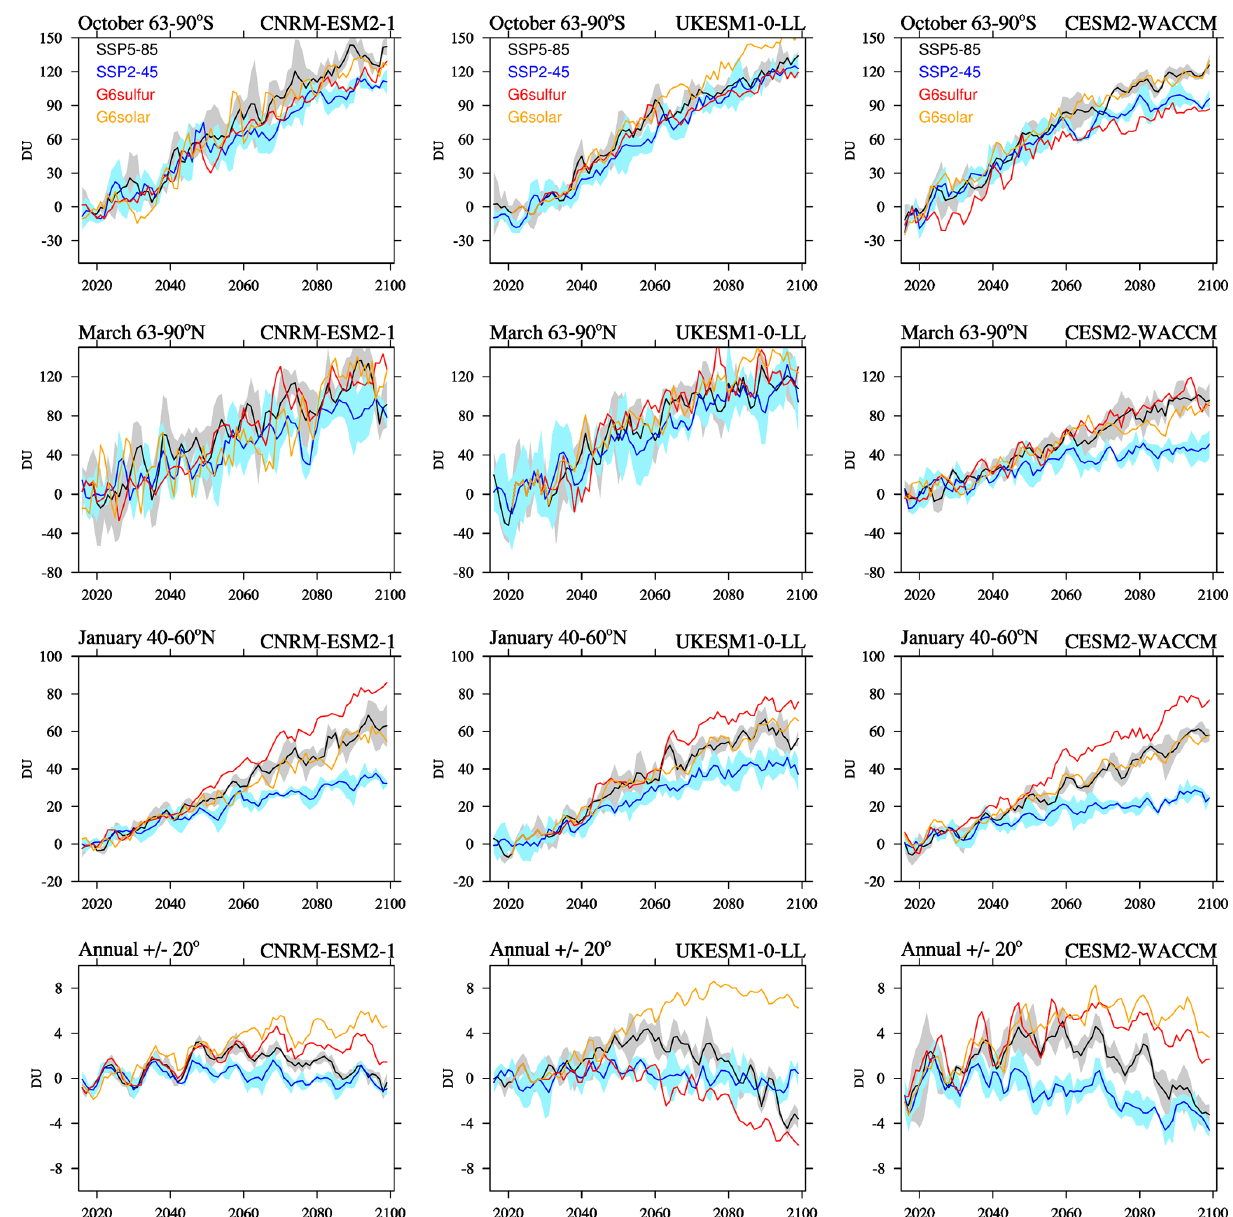
Figure 8. Ensemble mean of the total column ozone evolution between 2020 and 2100 normalized to 2020 values for different experiments (different colors) and four different regions and seasons (different rows) and three models (different columns). The 2 σ standard deviation of the ensemble mean is only shown for SSP5-8.5 and SSP2-4.5 scenarios for better